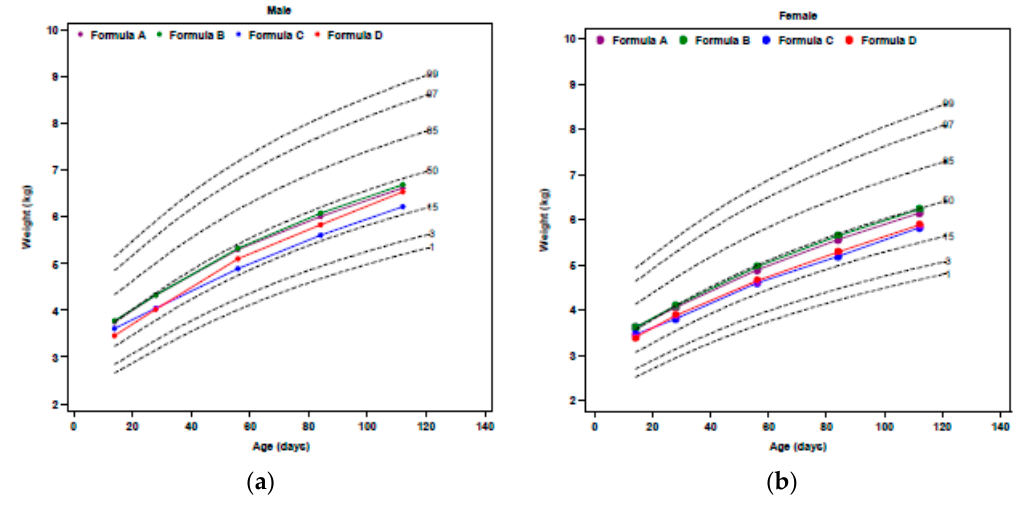
Figure 1. Mean weight-for-age percentiles (World Health Organization (WHO)) of evaluable healthy term infants at 14 day, and one, two, three and four months of age fed extensively hydrolyzed protein-based (EHFs). ( a ) WHO weight-for-age percentiles of male infants; ( b ) WHO weight-for-age percentiles of female infants. Mean weight of infants fed EHF-A and EHF-B were not statistically significantly different during the first four months of life ( p > 0.05) and were significantly greater than those fed EHF-C and EHF-D at 2 weeks and at 1, 2, 3, and 4 (EHF-C only) months of age ( p < 0.05). Data source: EHF-A [15]; EHF-B [14]; EHF-C [17]; EHF-D [17].